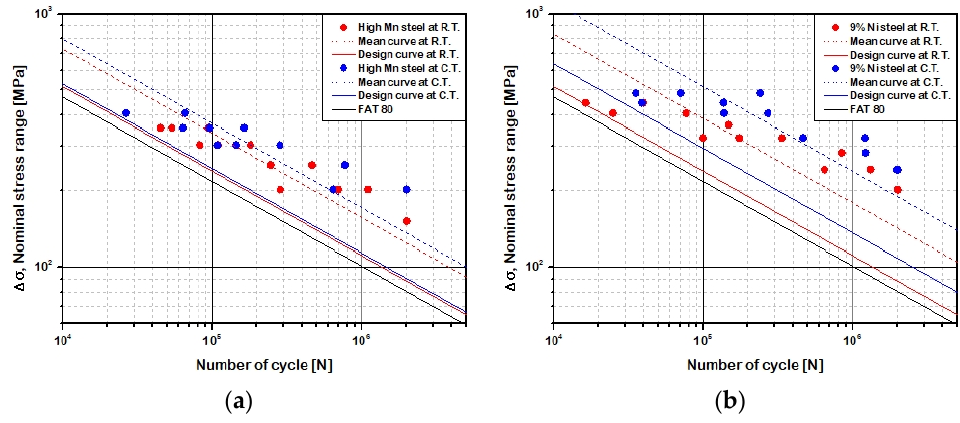
Figure 12. S-N curve of the weld metals compared to the IIW FAT 80 class: ( a ) high Mn; ( b ) 9% Ni.